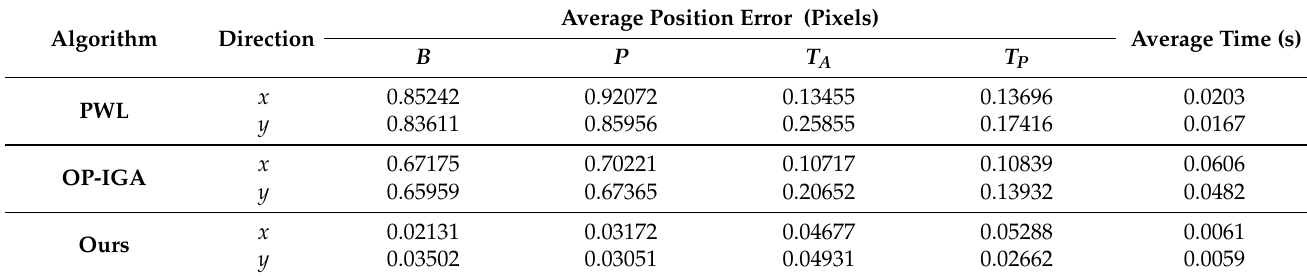
Table 6. Average position error of different methods and average time